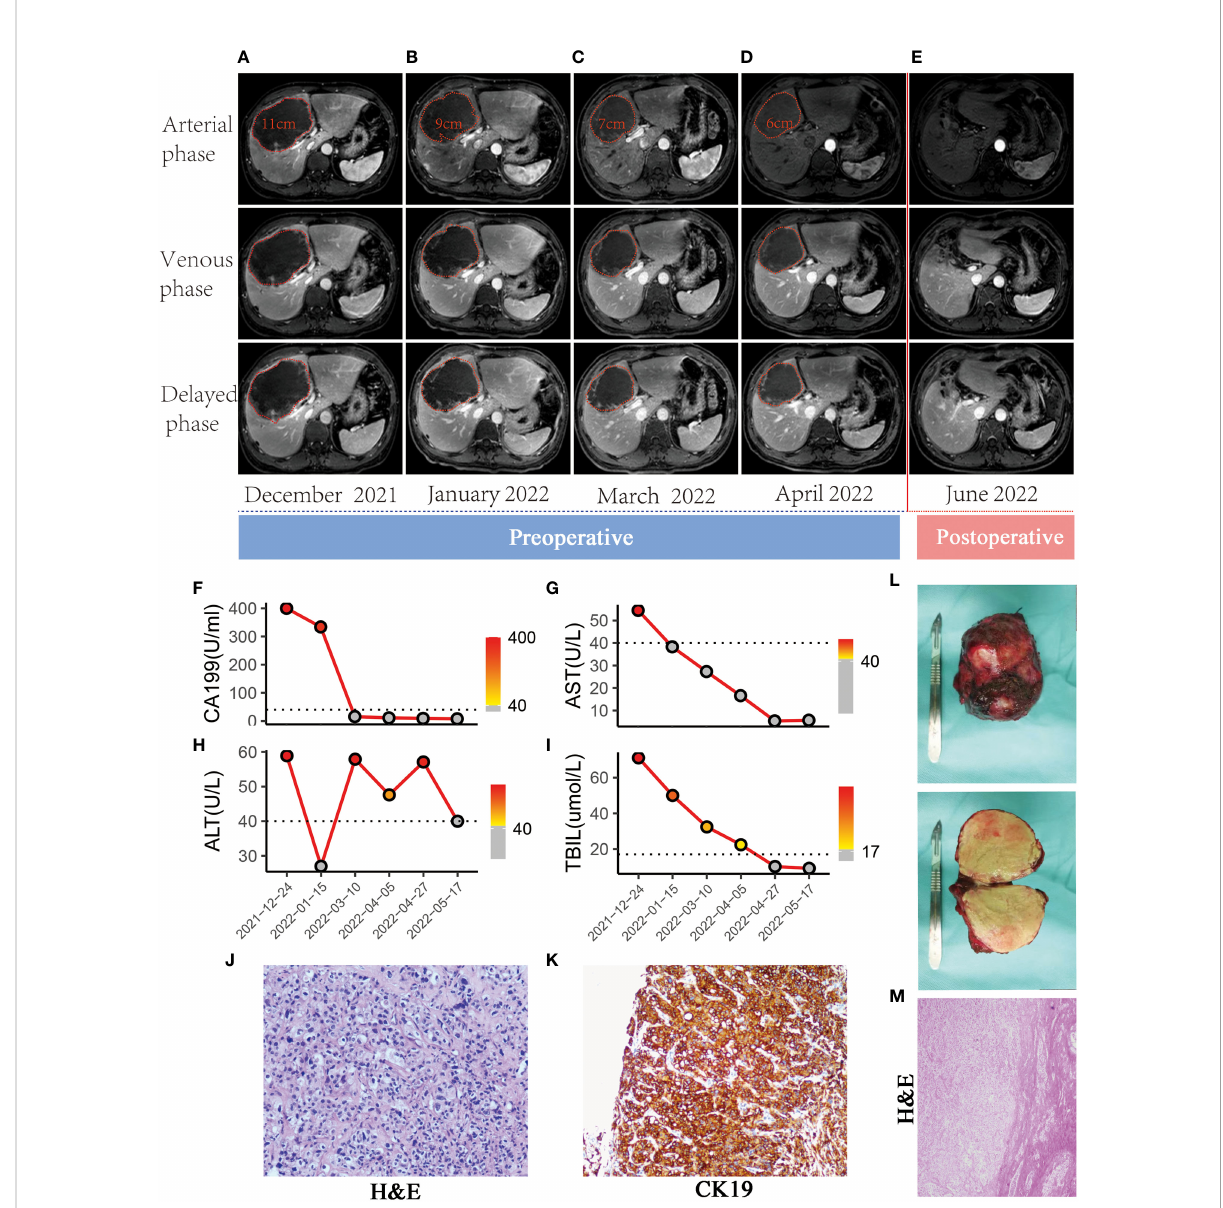
FIGURE 1 Imaging, laboratory tests, and pathology of the patient. (A – E) After systemic chemotherapy, the tumor size was reduced from 11 to 6 cm, and the patient was then treated with surgery. Postoperative imaging revealed no tumor lesions. (F) CA199 level decreased from 400 U/mL to 15 U/ mL and remained normal thereafter. (G – I) The liver function damage could be controlled. AST, aspartate aminotransferase; DBIL, direct bilirubin; TBIL, total bilirubin. (J) H&E staining of the biopsy tissue (400× magni fi cation) showed poorly differentiated cholangiocarcinoma. (K) Immunohistochemistry revealed strong CK19 expression, suggesting cholangiocarcinoma. (L) Macroscopic fi ndings of the resected tumor (size: 7 × 7 × 6 cm). (M) H&E staining of the resected tissue (400× magni fi cation) suggested poorly differentiated cholangiocarcinoma and pathological necrosis of the tumor. No microvascular invasion was